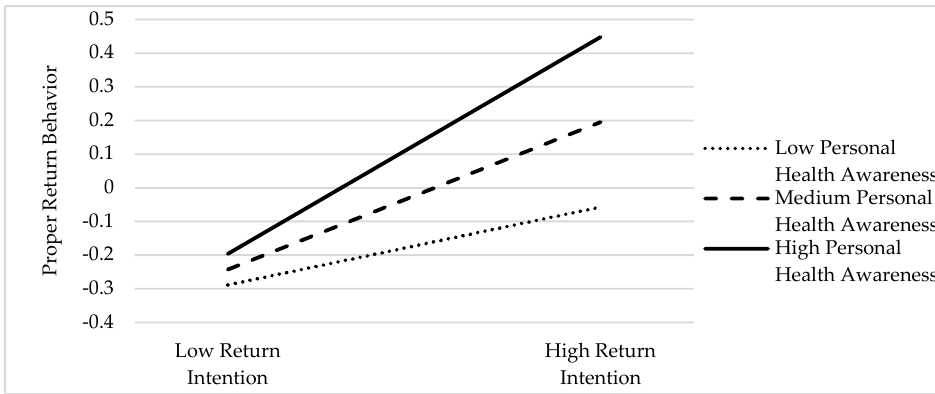
Figure 4. The analysis of moderating effect.